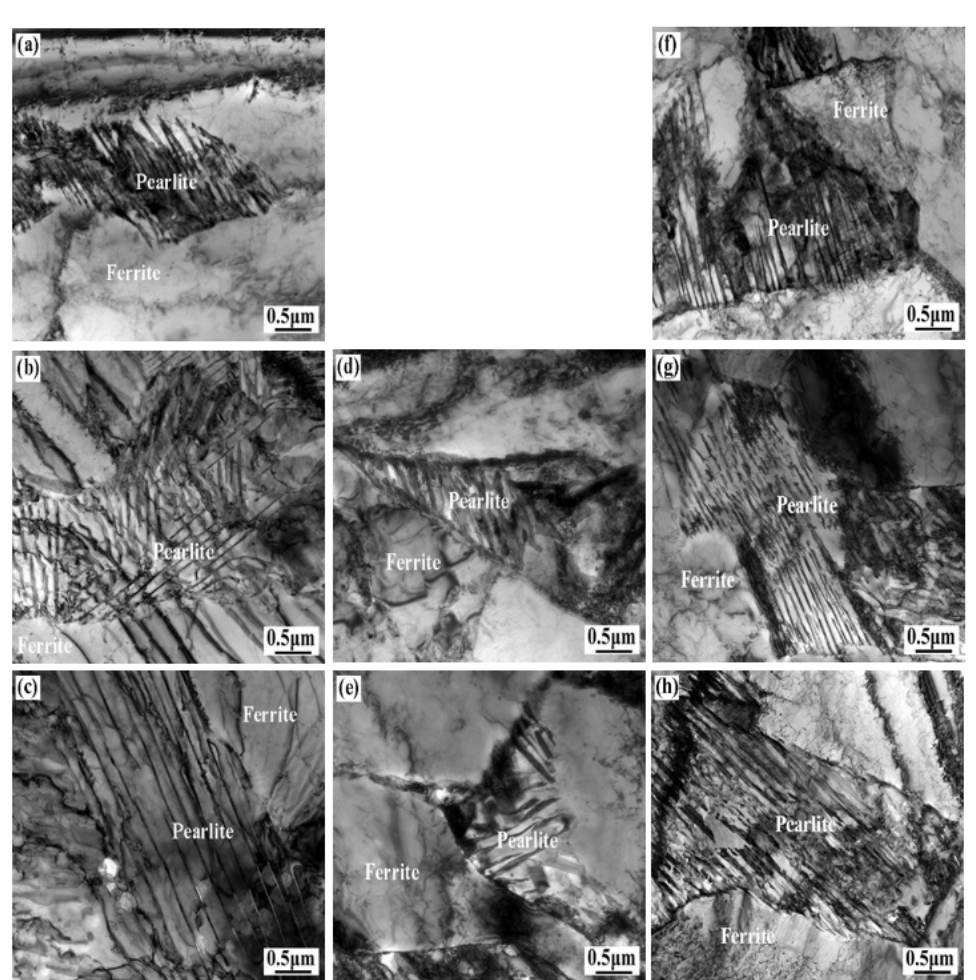
Figure 8. TEM micrographs at the different temperature measurement points. Images ( a – h ) show the results for points P1–P8, respectively.